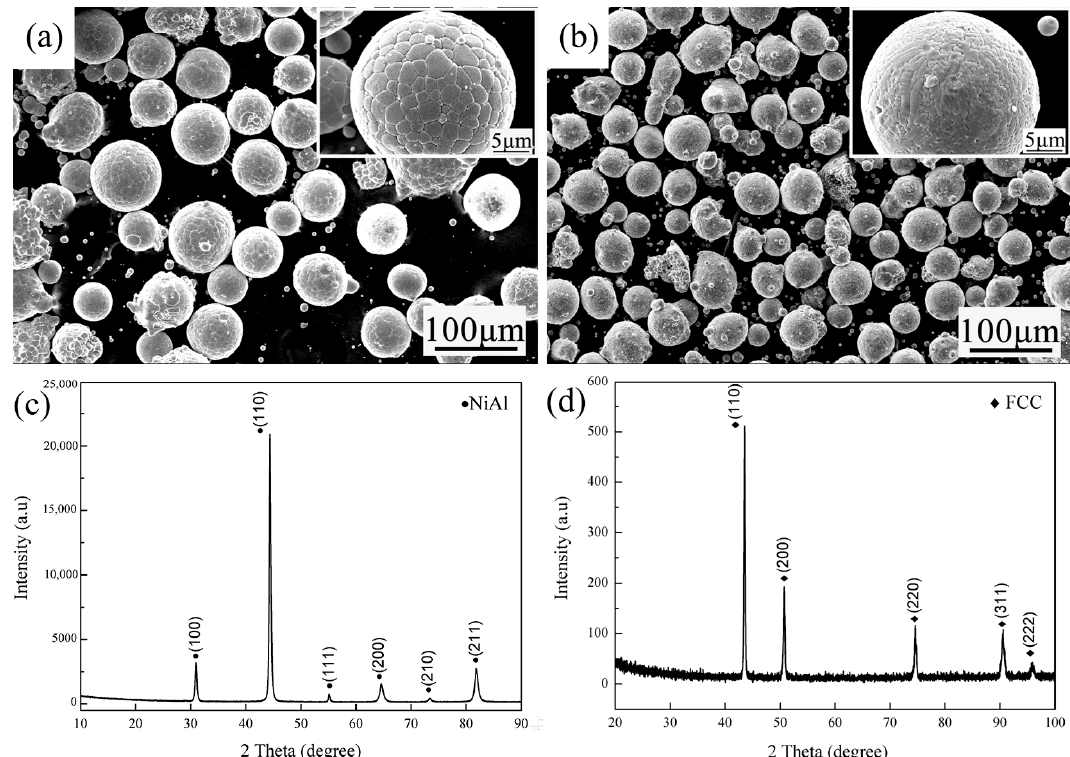
Figure 1. Scanning electron microscopy (SEM) images of the gas atomized NiAl powders ( a ) and CrMnFeCoNi high-entropy alloy (HEA) powders ( b ); X-ray diffraction (XRD) patterns of NiAl ( c ); and CrMnFeCoNi HEA ( d ).